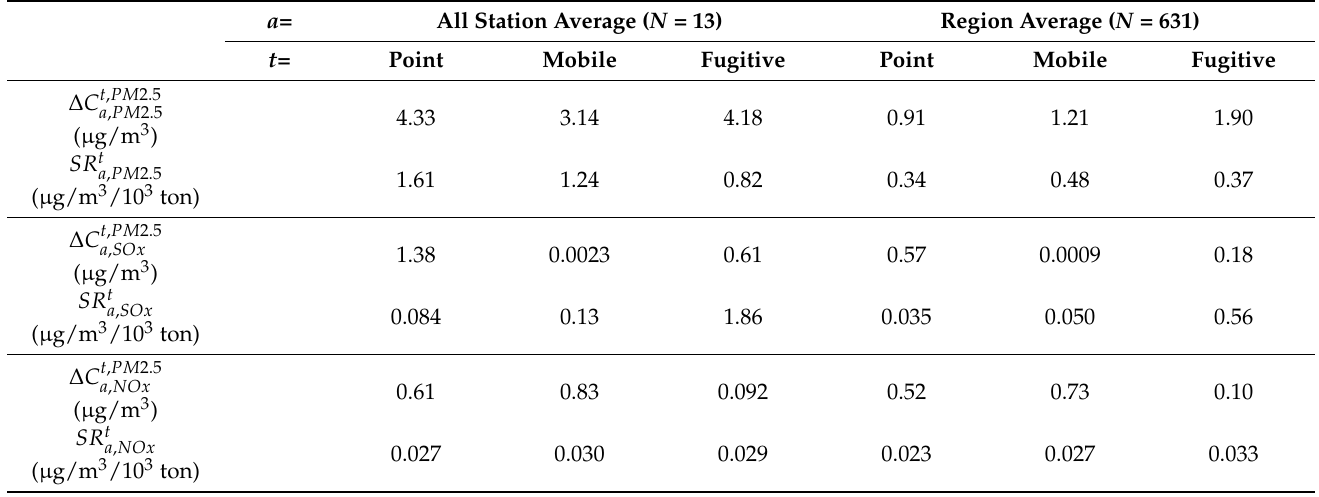
Table 2. Quantification of the impact empty( ∆ C t , PM 2.5 a , s ) and sensitivity ( SR t a , s ) of various pollutant